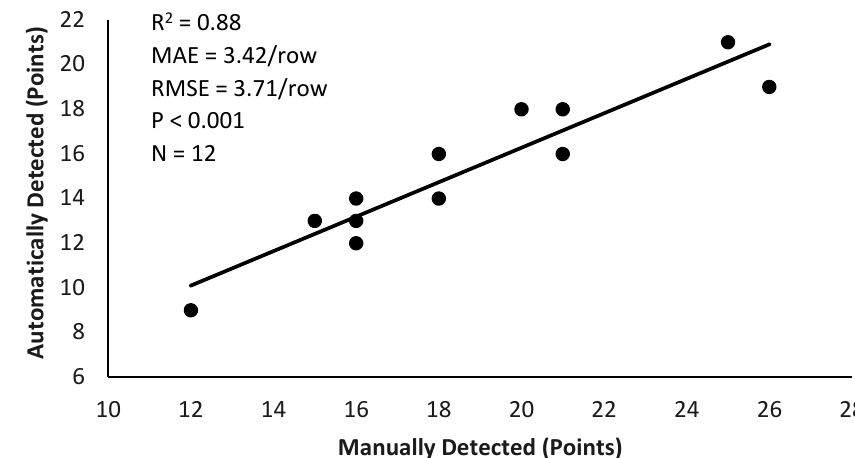
Figure 10. Correlation between manually and automatically detected points for field site II.